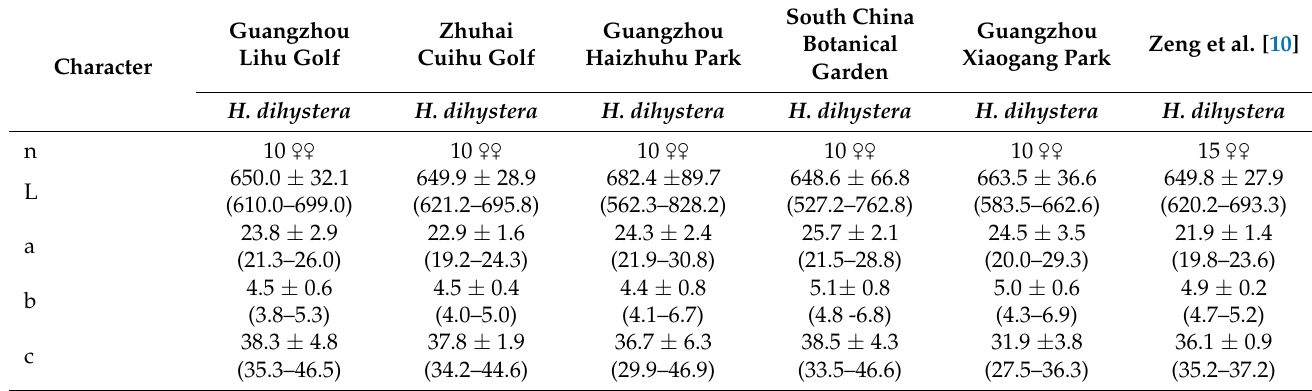
Table 4. Morphometrics of females of Helicotylenchus dihystera populations mounted in formalin– glycerin in this study compared to those reported by Zeng et al. [10]. All measurements in µ m and in the format: mean ± s.d.